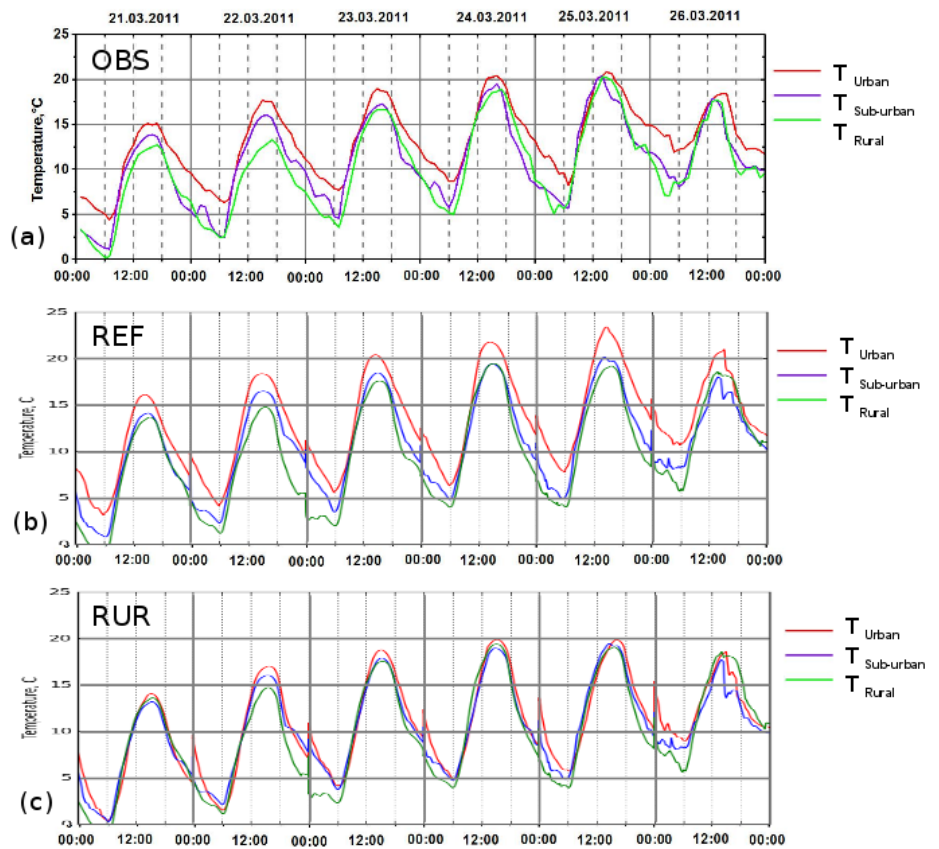
Fig. 4. Diurnal variation of hourly near-surface air temperature (in ◦ C) at urban, suburban and rural stations measured (from Pal et al., 2012) (a) , predicted with REF simulations (b) and RUR simulations (c) .